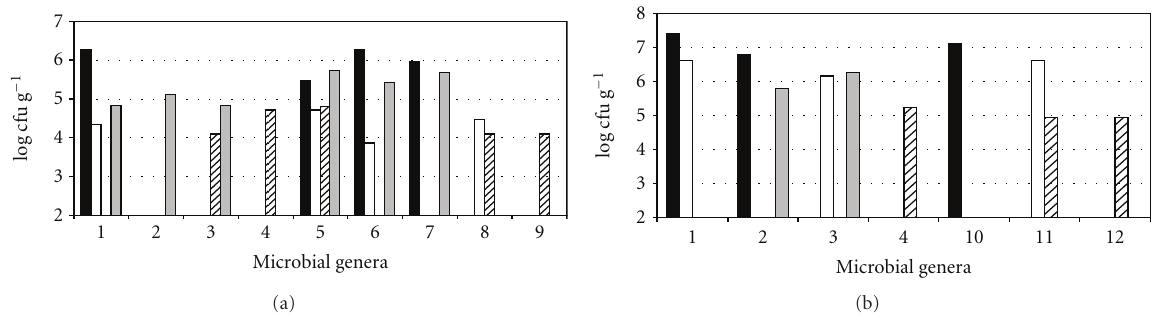
Figure 2: Distribution of bacterial genera and relative total load from zucchini female flower pistils in trial A and trial B after 0 (black bars), 4 (white bars), 8 (diagonal stripes bars), and 11 (grey bars) days of cold storage at 4 ◦ C. Bacterial genera are defined as: 1, Acinetobacter spp.; 2, Serratia spp.; 3, Klebsiella spp.; 4, Pantoea spp.; 5, Erwinia spp.; 6, Arthrobacter spp.; 7, Staphylococcus spp.; 8, Weissella spp.; 9, Pseudoclavibacter spp.; 10, Enterobacter spp.; 11, Pseudomonas spp.; 12, Bacillus